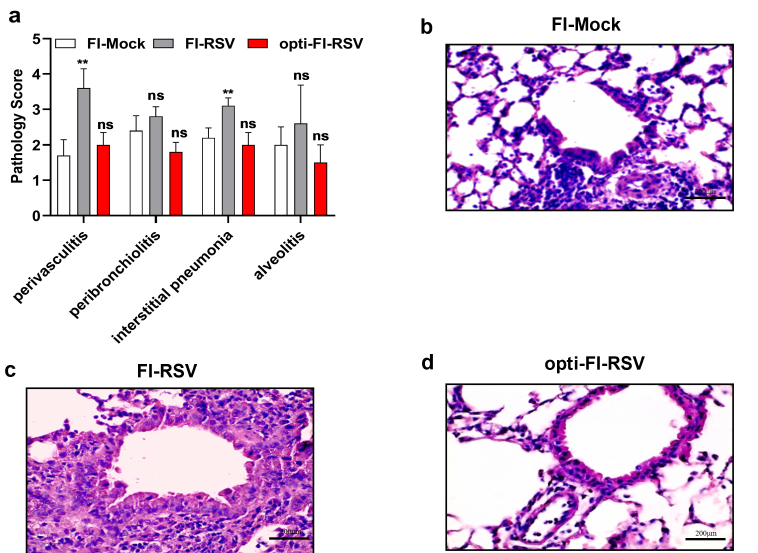
Figure 4. Histopathology following RSV challenge in cotton rats. To evaluate for vaccine attributable enhanced disease post challenge, groups of five cotton rats were inoculated intramuscularly with FI-Mock, FI-RSV, and opti-FI-RSV. All animals were challenged with A2 on day 49 p.i. Left lungs were harvested on day 5 after challenge, and histopathology scoring was performed. Pathology score was calculated as described in the method ( a ). Representative haematoxylin and eosin stains for ( b ) FI-Mock, ( c ) FI-RSV, ( d ) opti-FI-RSV vaccinated rats are shown. Scale bars represent 200 µ m. The bars/lines indicate the mean ± SD. ( a ) The data were analyzed by Kruskal-Wallis test (nonpara- metric) to analyze the differences between vaccination groups. The p values are shown by asterisks (ns = not significant; ** p <